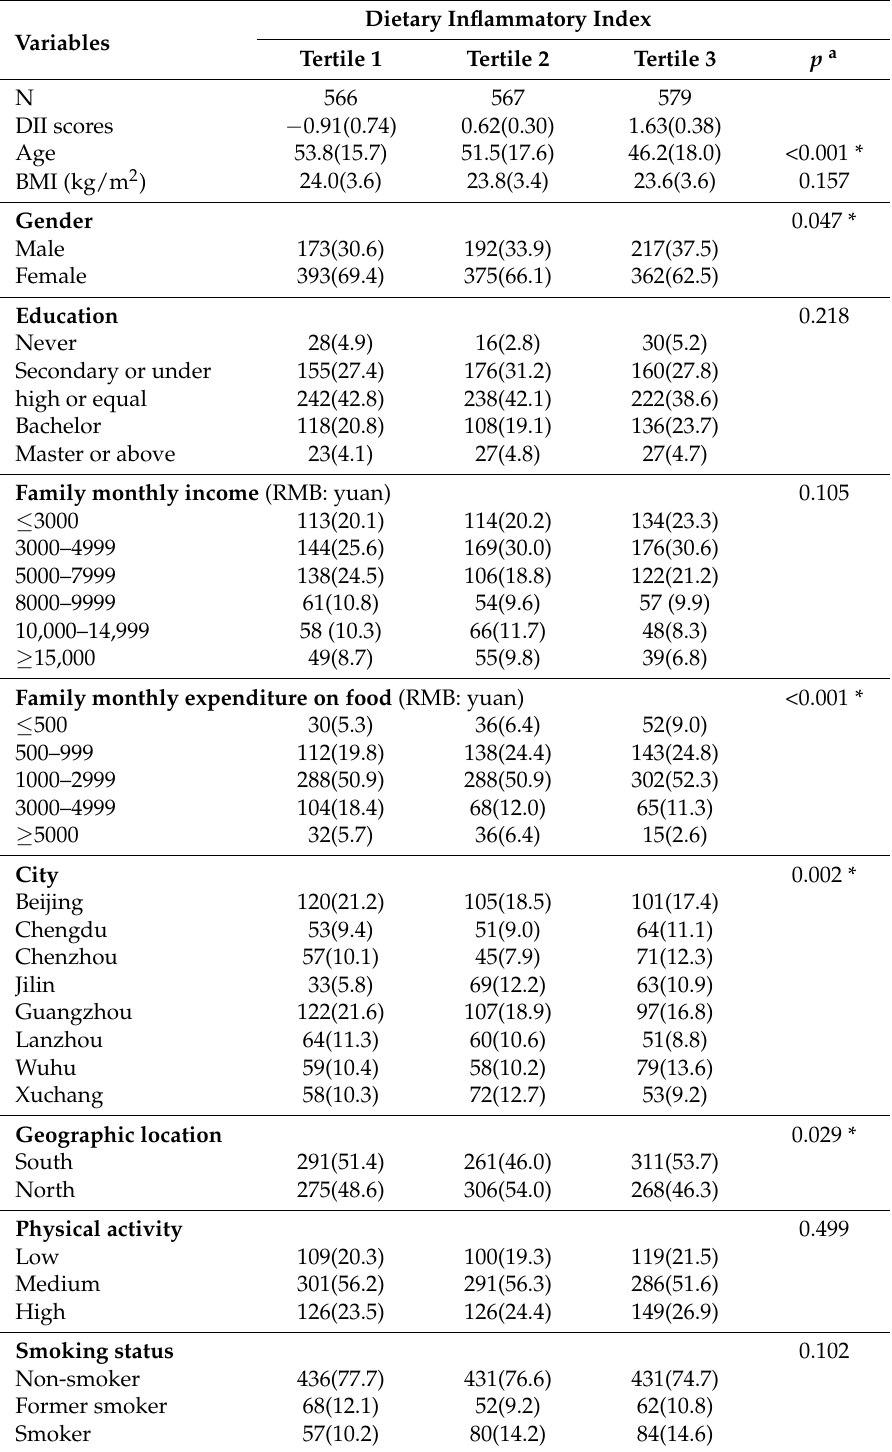
Table 1. Baseline characteristics of tertiles of the DII score, Mean ± SD or N